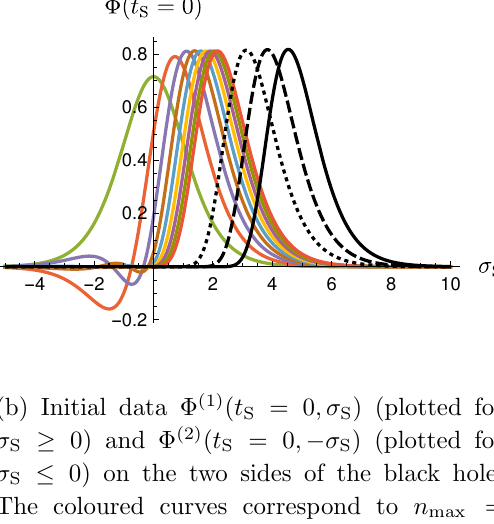
σ S ) (plotted for −